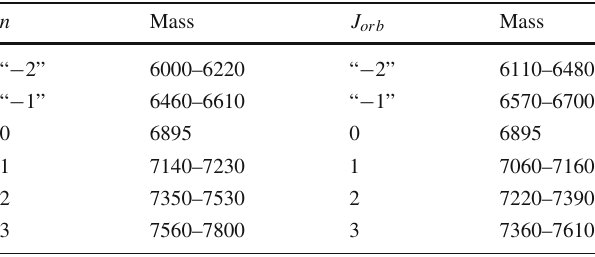
Fig. 4 Radial HMRT of the X ( 6900 ) with α (cid:2) = α (cid:2) The X ( 6900 ) is placed at n = 0 although it might not be the ground state. The resonances at 6490 MeV at 7240 MeV, placed here at n = − 1 and 1 respectively, both fit the trajectory well. The next few states are at 7530, 7800, and 8050 MeV